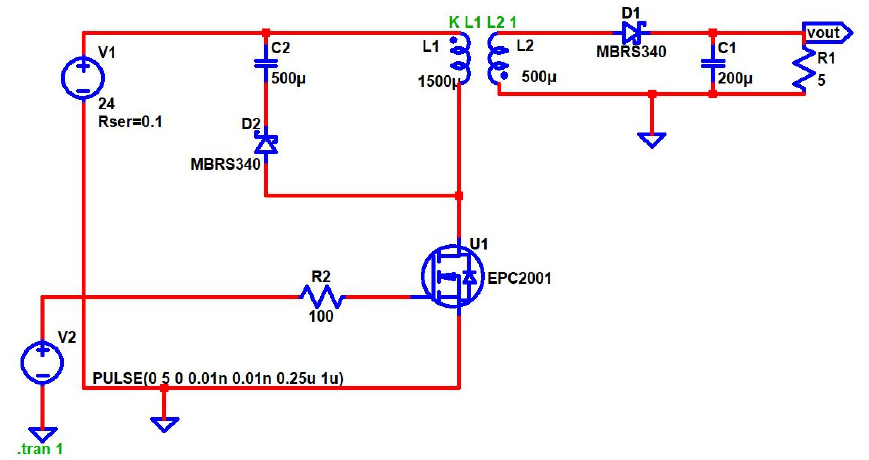
Figure 10. DC-to-DC flyback converter with resistive load of 5 Ω .